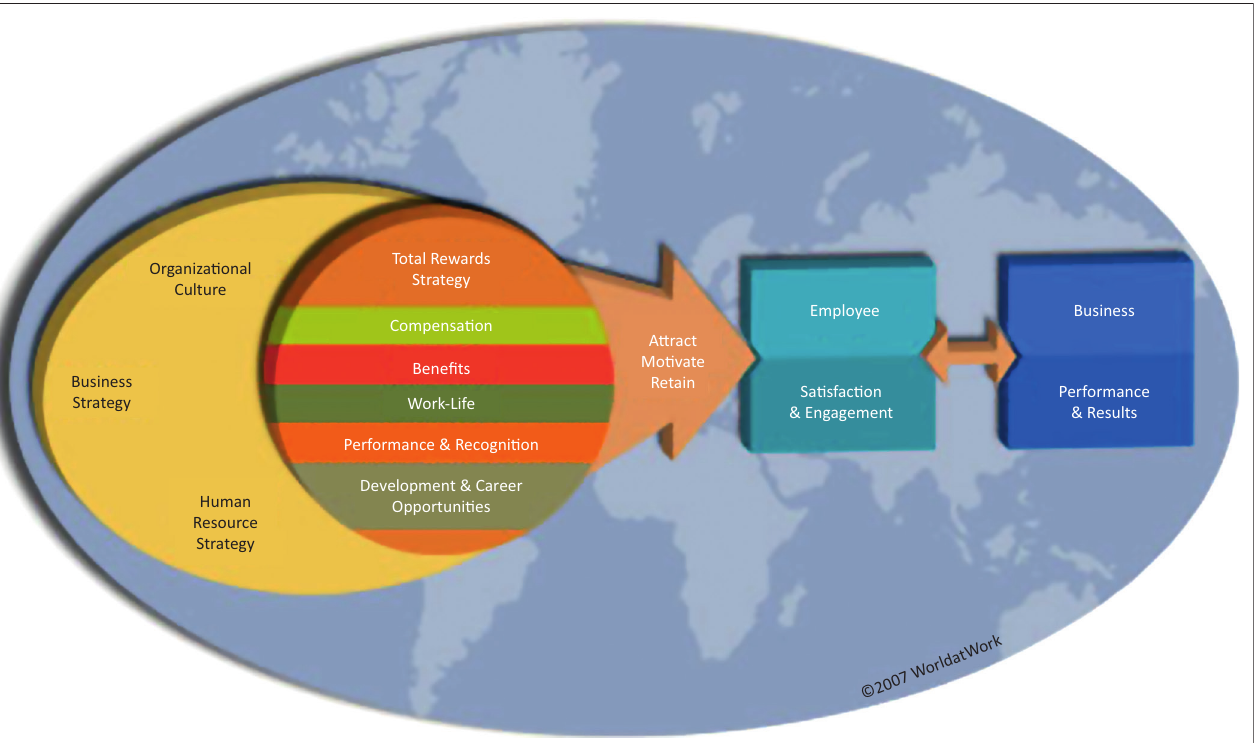
FIGURE 1: WorldatWork total rewards